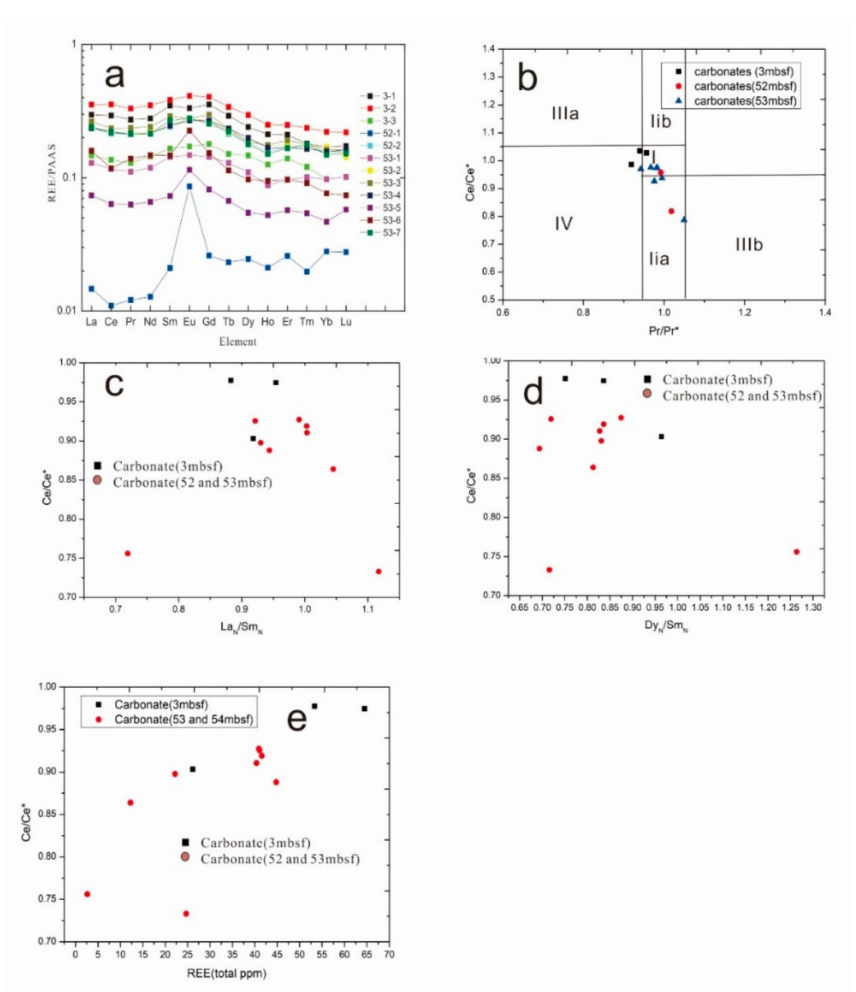
Figure 5. ( a ) Shale-normalized REE pattern of the seep carbonates. ( b ) Plot of Ce / Ce * with the La N / Sm N ; ( c ) plot of Ce / Ce * with the Dy N / Sm N ; ( d ) plot of Ce / Ce * with the Pr / Pr *; and ( e ) plot of Ce / Ce * with the